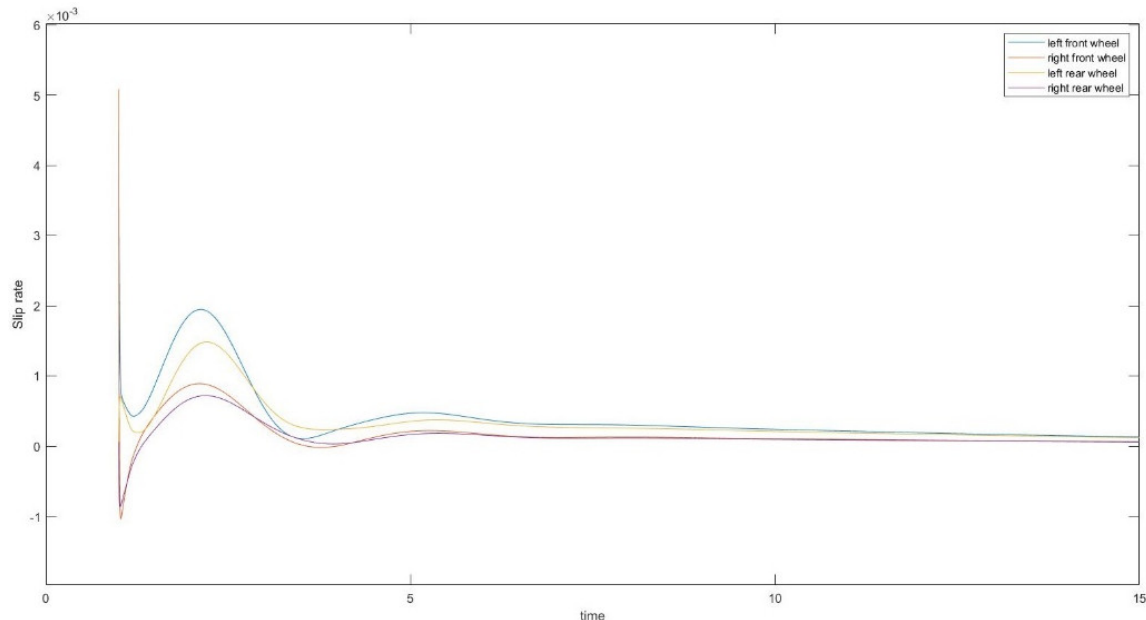
Figure 14. Car model connecting the frame with tires in X language.